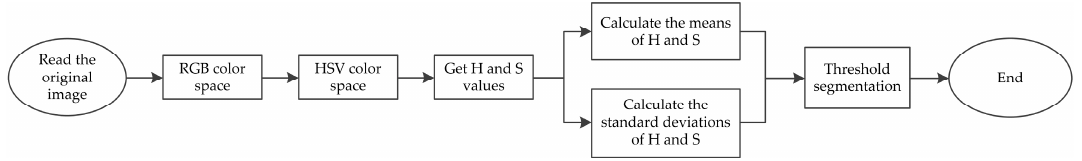
Figure 2. Converting the RGB image to the HSV image.